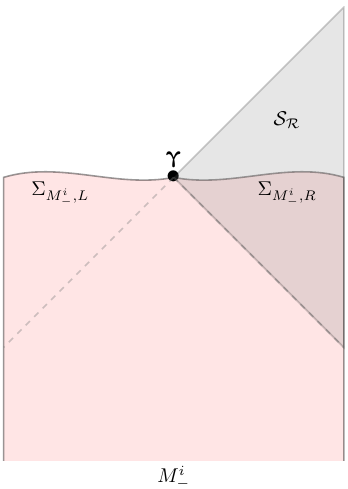
Figure 3 . The ‘right shadow’ S R (shaded in gray) is the maximal AdS-Cauchy development of Σ . Note that S R includes regions both to the past and to the future of Σ M i ,R − the past also lies in M i (shaded pink), while the region to the future does not. The intersection of − S R and M i has both −